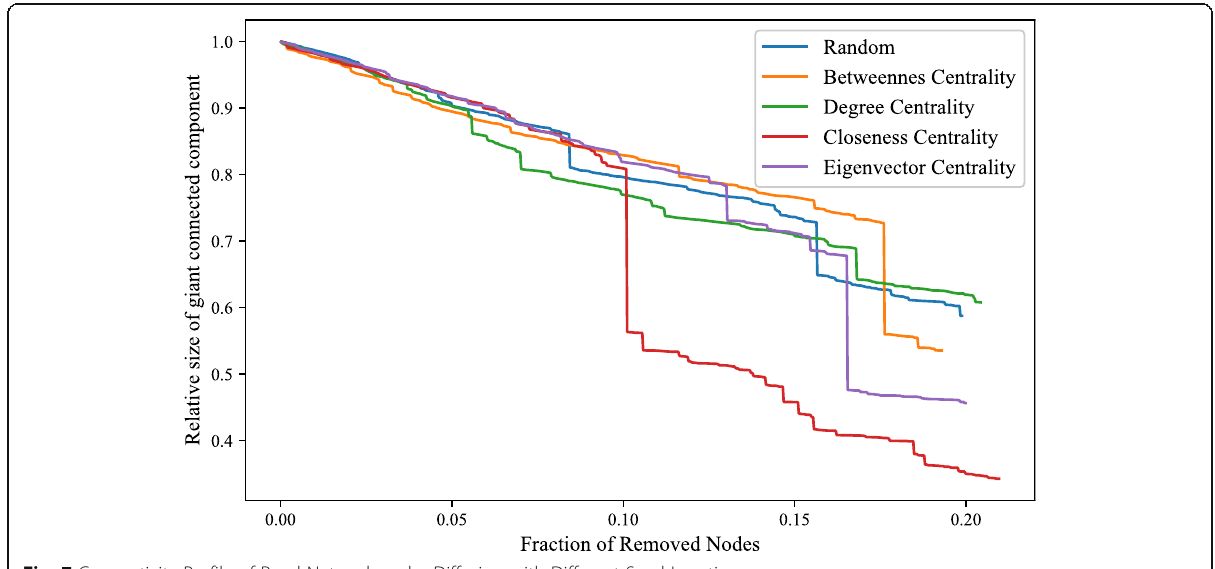
Fig. 7 Connectivity Profile of Road Network under Diffusion with Different Seed Locations